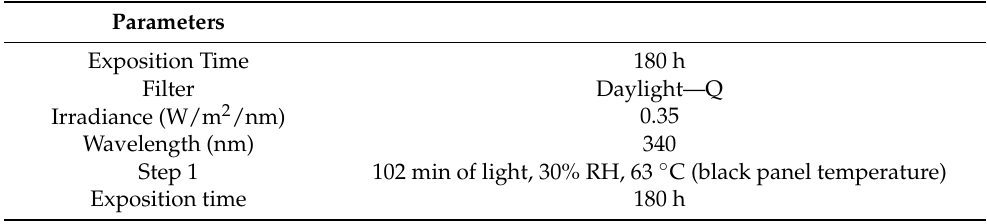
Table 2. Parameters used for accelerated UV